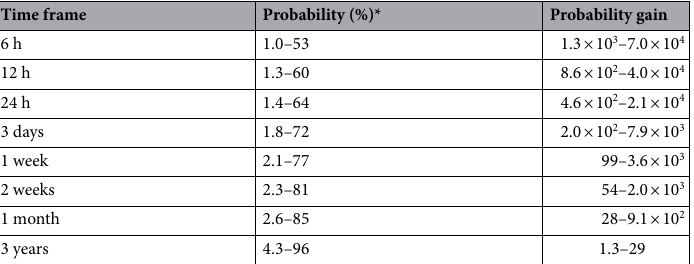
Table 1. Probability and probability gain for successive occurrence of great Nankai megathrust earthquakes within different time frames. *Probability of a subsequence earthquake to occur within a designated time frame after the occurrence of the first